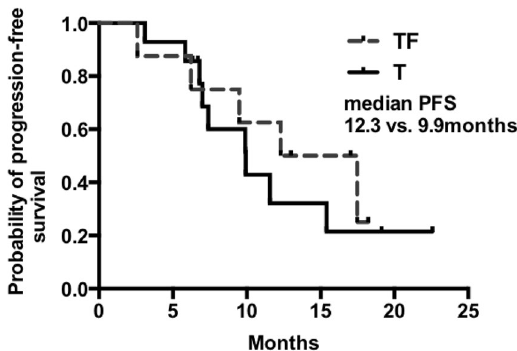
Figure 1. Kaplan-Meier estimates of the progression-free survival of patients treated with docetaxel plus fulvestrant (TF) and with docetaxel monotherapy